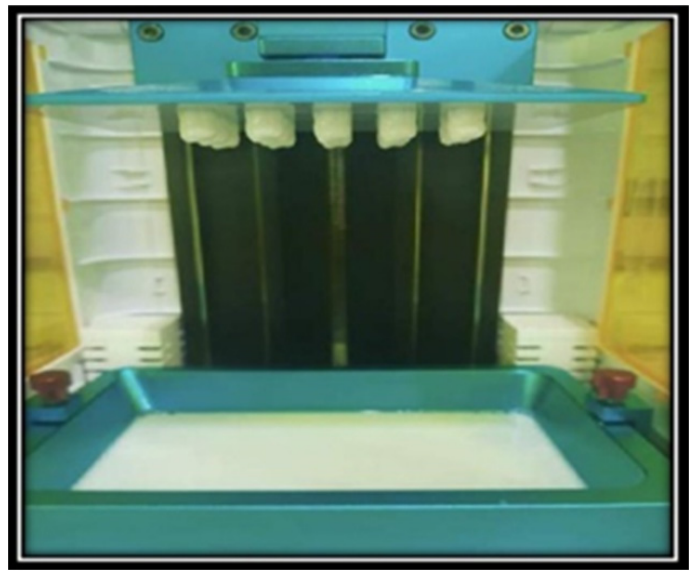
Figure 4. Printing of acrylonitrile–butadiene–styrene (ABS) resin